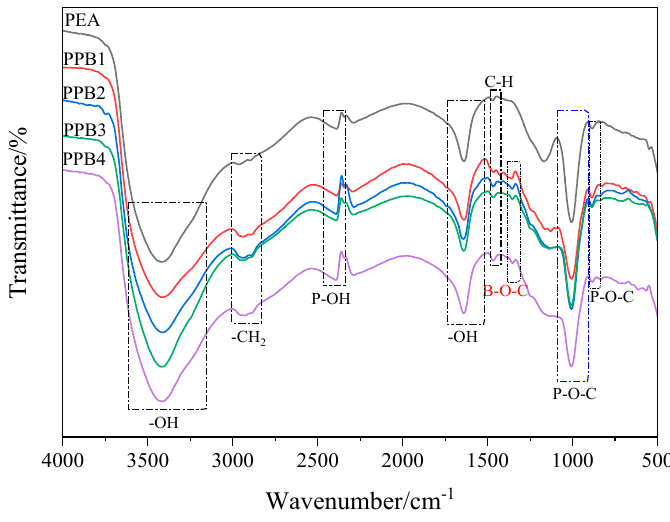
Figure 2. FTIR spectra of the PPBs flame retardants.